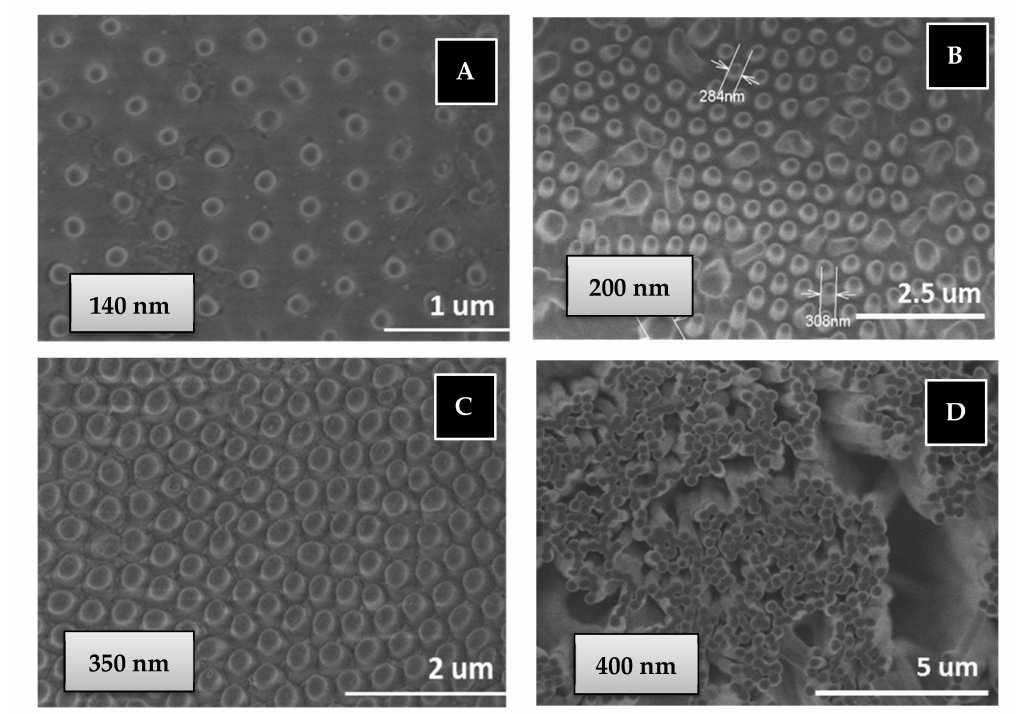
Figure 7. SEM images of PBMA nanopillars obtained by free radical polymerization ( B ) or infiltration ( A , C , D ) in AAO templates: ( A ) 140 nm diameter and 1 µ m length; ( B ) 200 nm diameter and 2 µ m length; ( C ) 350 nm diameter and 1 µ m length; ( D ) 400 nm diameter and 100 µ m